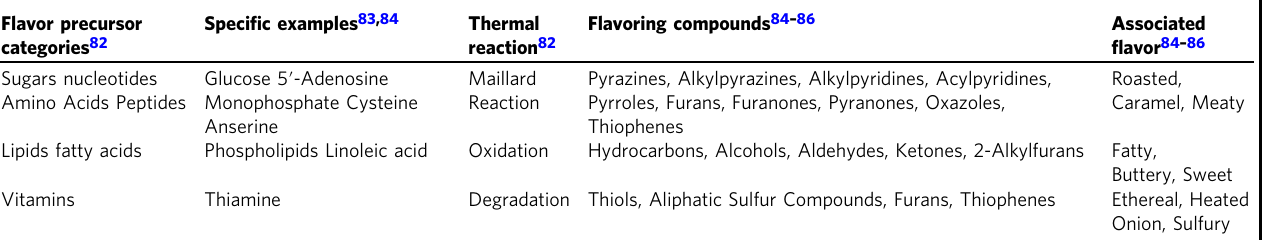
Table 2 Precursors and compounds attributable to the aroma and fl avor of